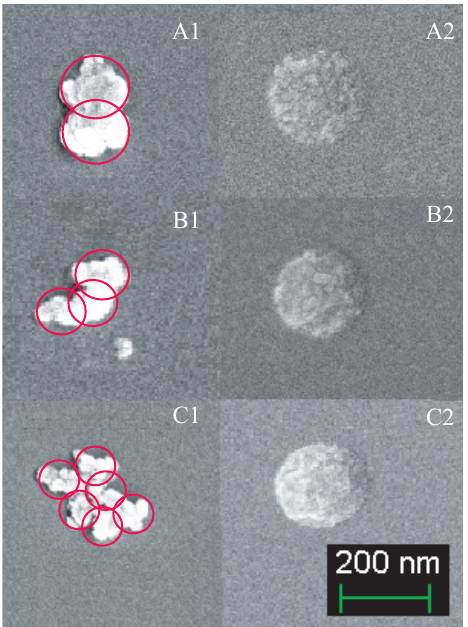
Figure 1. SEM images of the particles obtained from 700ppb α - pinene and sampled for a central mobility diameter of 180.0nm. The aerosol particles were collected on the silica substrate for 12h and then coated with 5nm of Pt / Pd. The voltage for the electron beam was 5kV, and the working distance was 2.3mm. Column 1 shows dimer, trimer, and higher-order agglomerates of the granu- lar monomers for < 5%RH. Red circles identify the monomers. Column 2 shows nearly spherical particles that were collected after exposure to 80%RH followed by drying to < 5%RH.